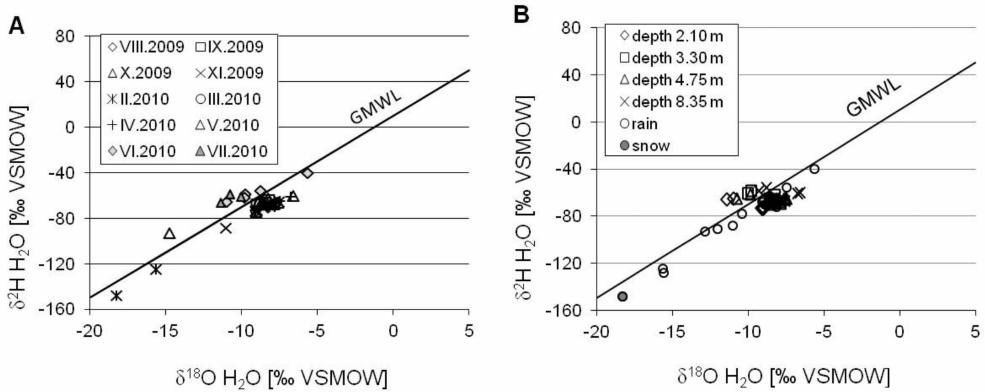
Figure 6. The δ 2 H vs. δ 18 O relationship in groundwater of the Po˙zary aquifer. Di ff erentiation of isotopic composition is shown for sampling seasons ( A ) and depth profile ( B ). Global Meteoric Water Line (GMWL) after [47]: δ 2 H = 8.13 × δ 18 O +